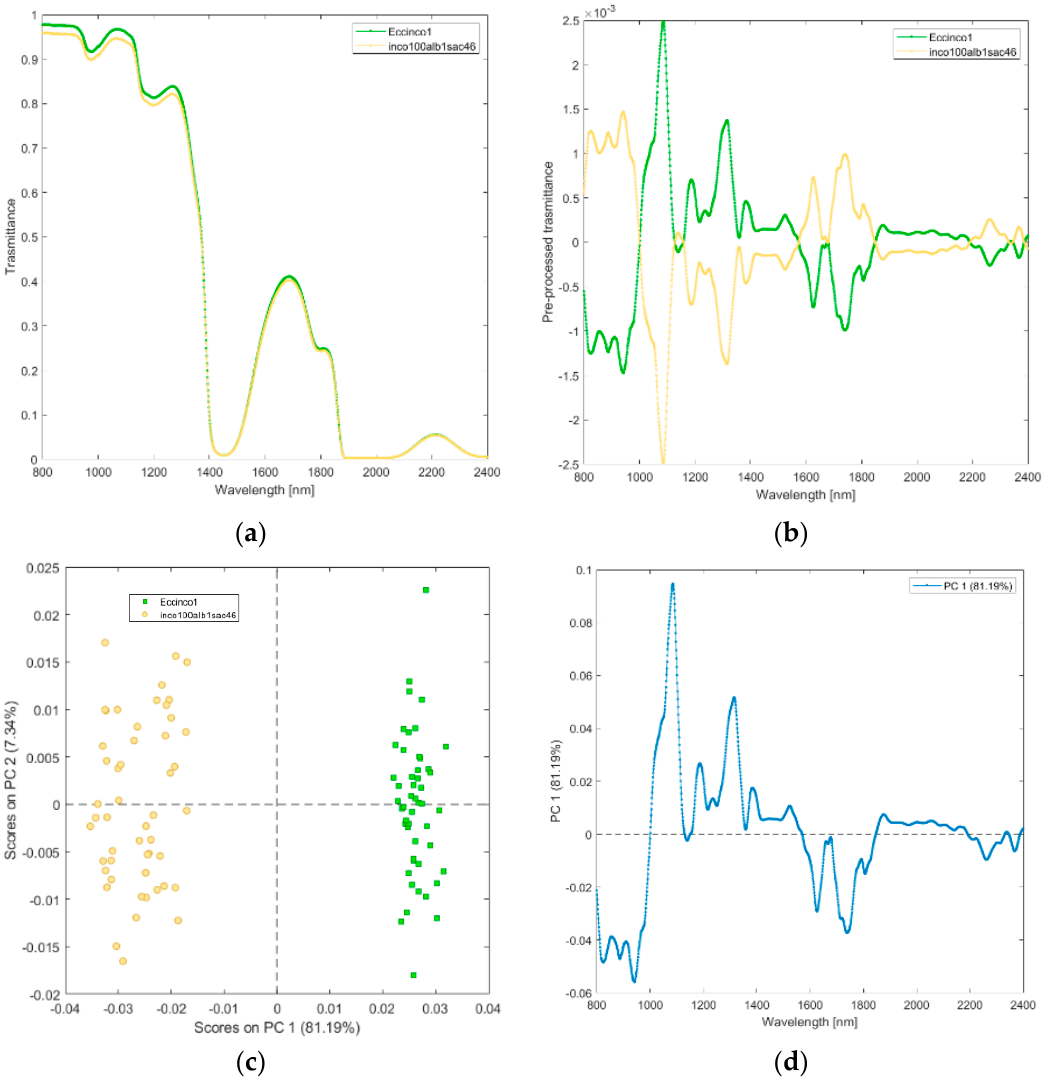
Figure 6. Average raw ( a ) and pre-processed ( b ) transmittance spectra for incobotulinum A toxin (inco100alb1sac46), and its excipients (EccInco). PC1 − PC2 score plot ( c ) and loading plot of PC1 ( d ) for incobotulinum A toxin (inco100alb1sac46), and its excipients (EccInco). (vi) Solutions of incobotulinum A toxin (inco100alb1sac46_4_), equiactive abobotulinum A toxin (abo400alb01lat2). The raw and pre-processed transmittance spectra of incobotulinum A toxin and its excipients are shown in Figure 7a,b. PCA scores plot and loadings plot are shown in Figure 7c,d. PC1 captured 97% of the total variance (Figure